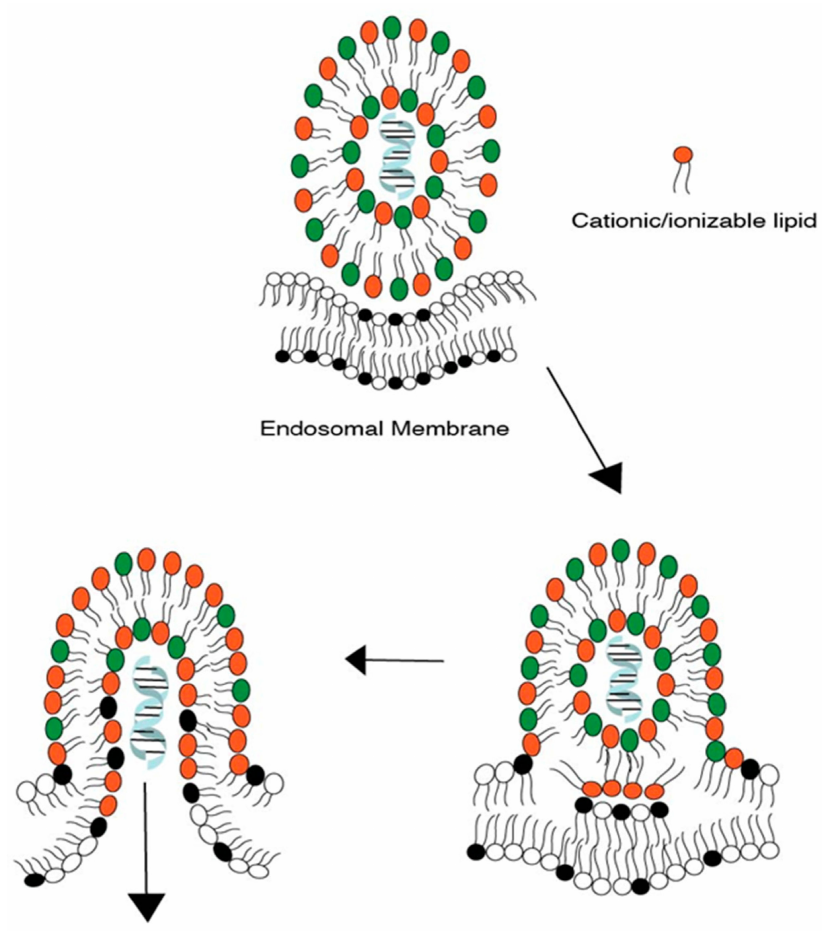
Figure 2. Release of cargo from an LNP after hexagonal phase formation and the subsequent assimilation/disruption of the endosomal membrane. Lipids with red head-groups represents ionizable lipids; lipids with green head-groups represent helper lipids and lipids with black head- groups represent negatively charged lipids on endosomal membrane. Drug cargo is represented by helical